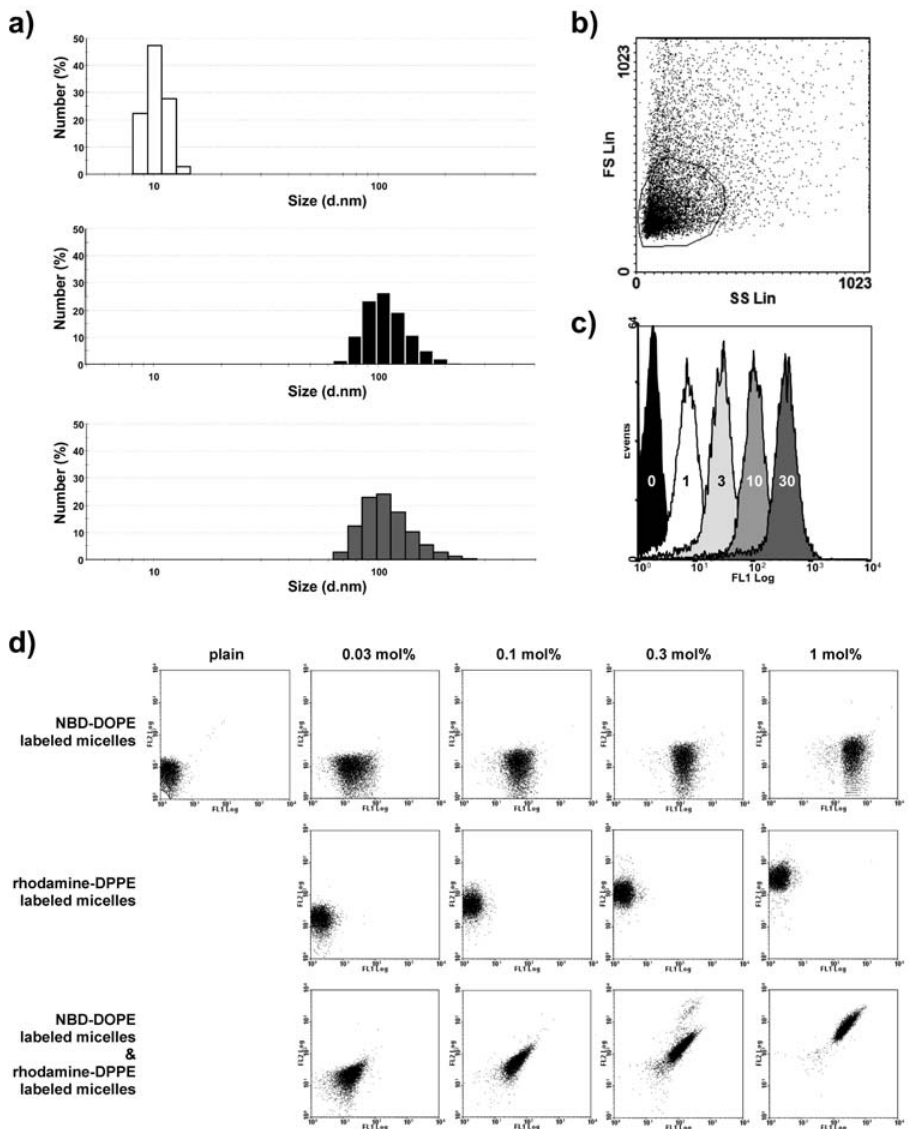
Figure 2. Postinsertion of dye-labeled Mal-PEG -DSPE-micelles into preformed 2000 liposomes. ( a ) Particle size distributions (numbers) of Mal-PEG -DSPE-micelles 2000 containing 10 mol% NBD-DOPE (white), plain liposomes before post-insertion (black), liposomes after post-insertion (grey); ( b ) Titration of micellar NBD-DOPE post-inserted into plain liposomes. Liposomes were detected using the flow cytometer showing the population of vesicles used for the analysis; ( c ) Liposomal fluorescence intensity after -DSPE-micelles containing indicated amounts of post-insertion using 1 mol% Mal-PEG 2000 NBD-DOPE (0 to 30 mol%); ( d ) Flow cytometry analysis of liposomes after post-insertion using indicated amounts of Mal-PEG -DSPE-micelles containing 10 mol% dye 2000 (NBD-DOPE or